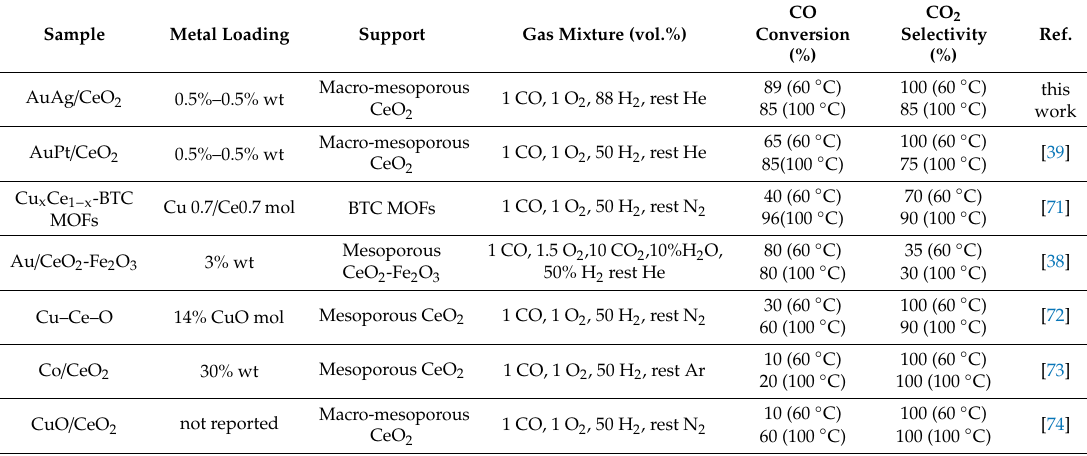
Table 2. CO-PROX activity of various mono and bimetallic catalysts reported on in the literature in comparison to the AuAg / CeO 2 sample investigated in this work.